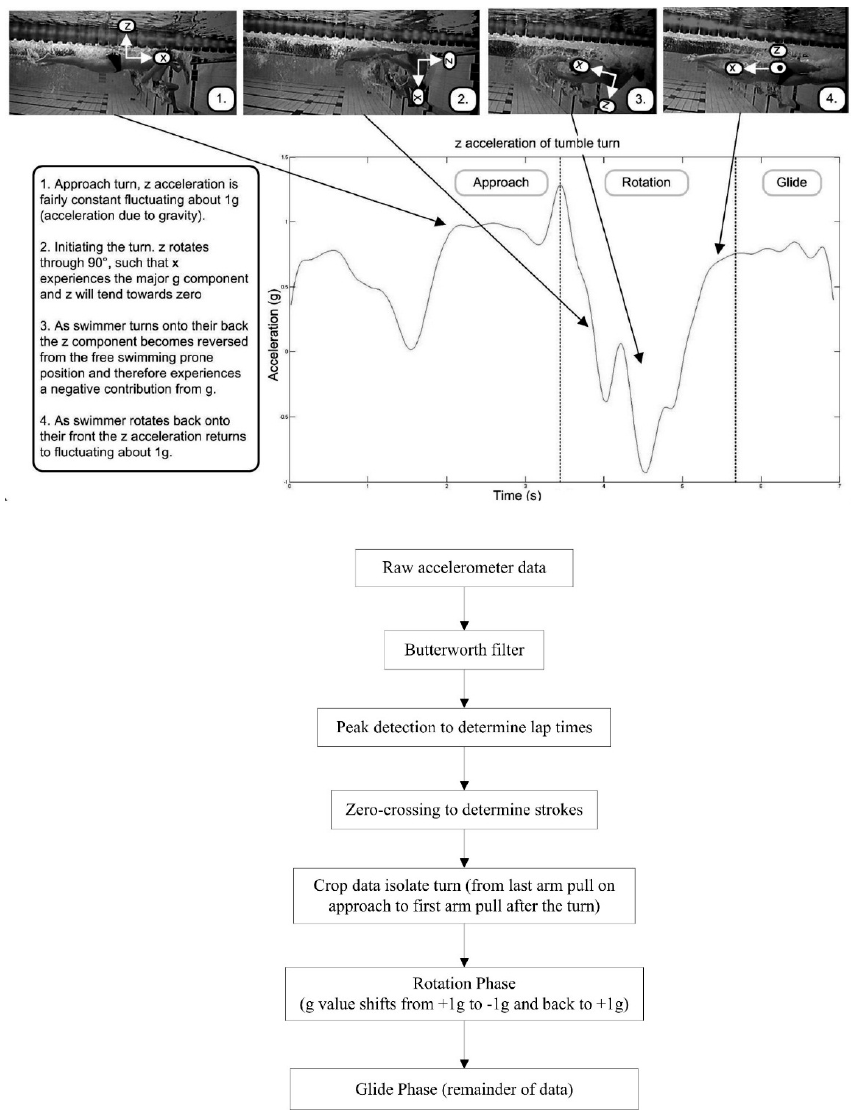
Figure 27. Flowchart of the process used to distinguish the approach, rotation and glide phases of the frontcrawl turn. Reproduced with permissions from Slawson, Justham, Conway, Le-Sage and West [69].